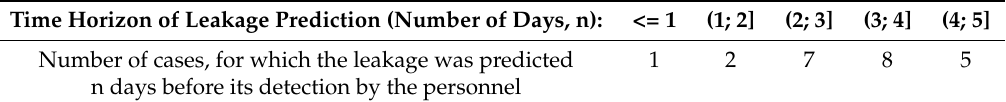
Table 2. Performance of the MPCA model in the detection of boiler